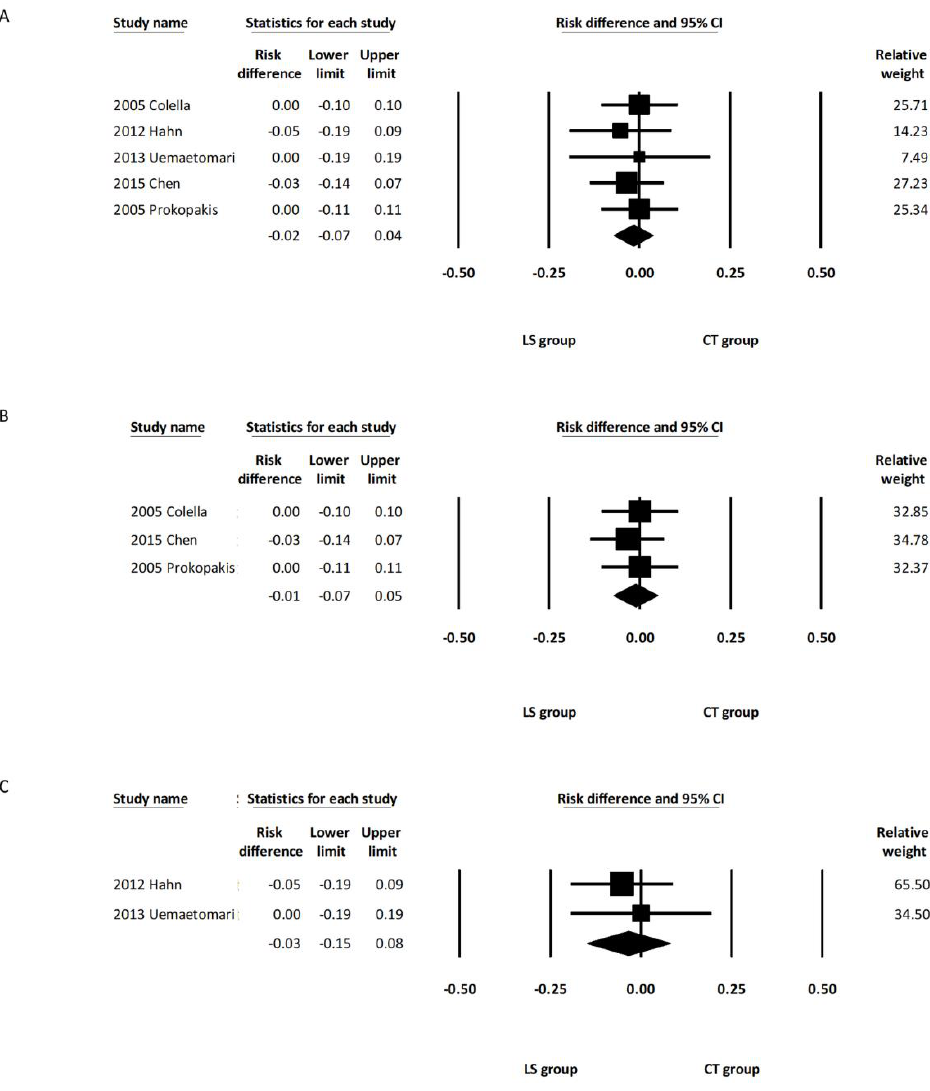
Figure 6. Forest plot of the incidence of bleeding complications after parotidectomy. ( A ) Overall study group. ( B ) Studies including only the LSP device. ( C ) Studies including only the LSJ device. LS, LigaSure; LSP, LigaSure Precise; LSJ, LigaSure Small Jaw; CT, conventional technique; CI confidence interval.